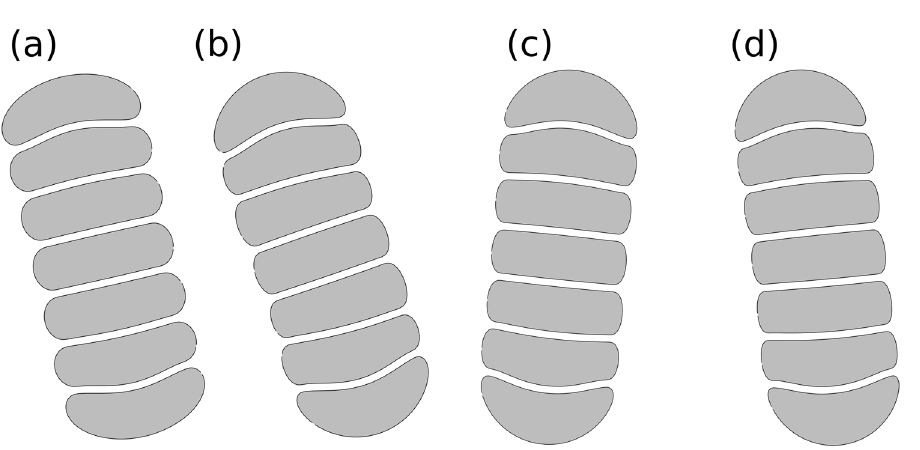
Figure 9. Simulations of clusters of 7 cells: ( a ) ε ad = 0.67 µ J/m 2 ; ( b ) ε ad = 2.55 µ J/m 2 ; ( c ) ε ad = 4.43 µ J/m 2 ; ( d ) = 6.93 µ J/m 2 ε ad